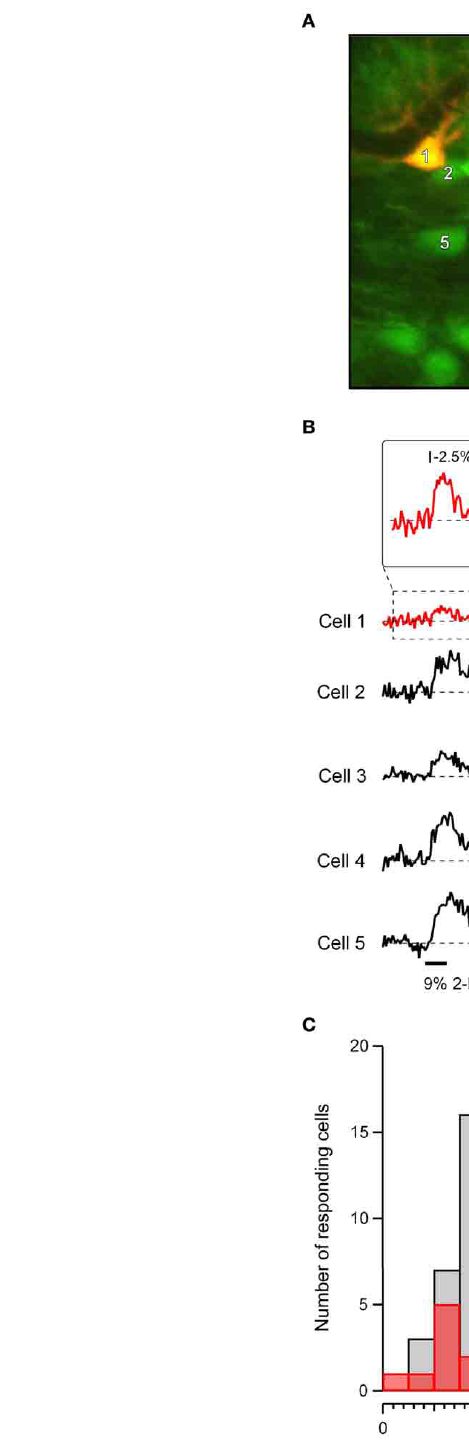
FIGURE A2 | Discrimination of neuronal and glial responses. (A) A merged image of a mRFP1-positive glial cell (red, excited at 950nm) in the area stained with Fura PE-3 AM (green, excited at 800nm). (B) Recordings of [Ca 2 + ] i from the identified glial cell (cell 1) and the four mRFP-negative cells (cells 2–5) marked with numbers in (A) . The inset above the trace for